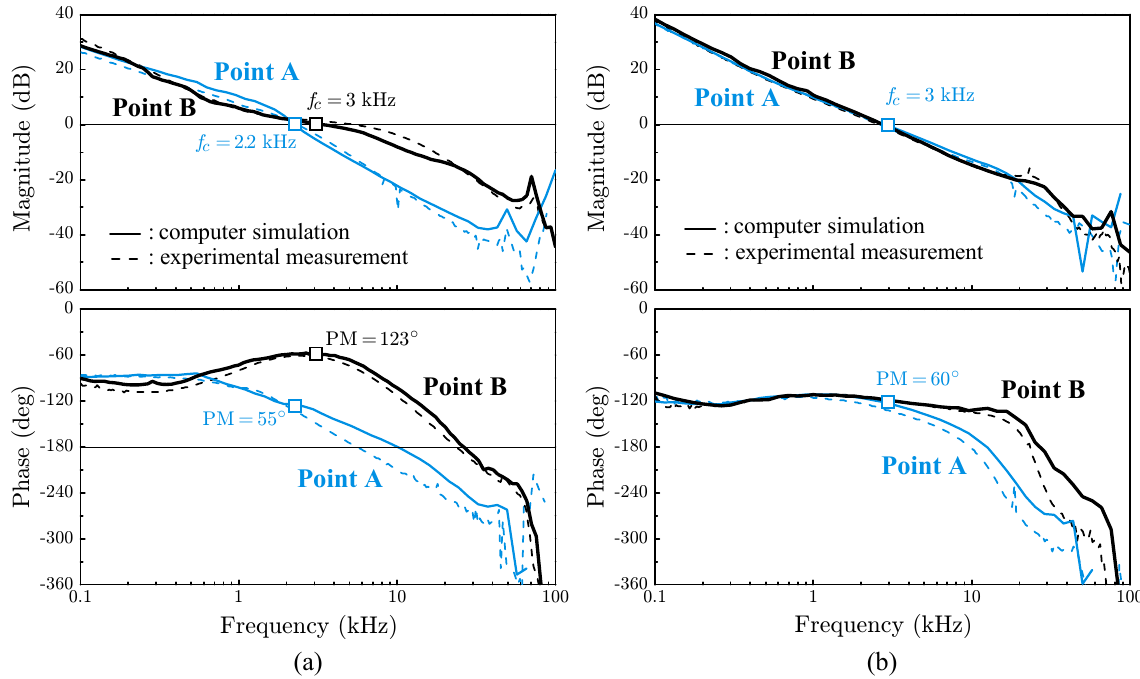
Figure 9. Loop gain characteristics of voltage mode control and proposed current mode control. ( a ) Voltage mode control; ( b ) Current mode